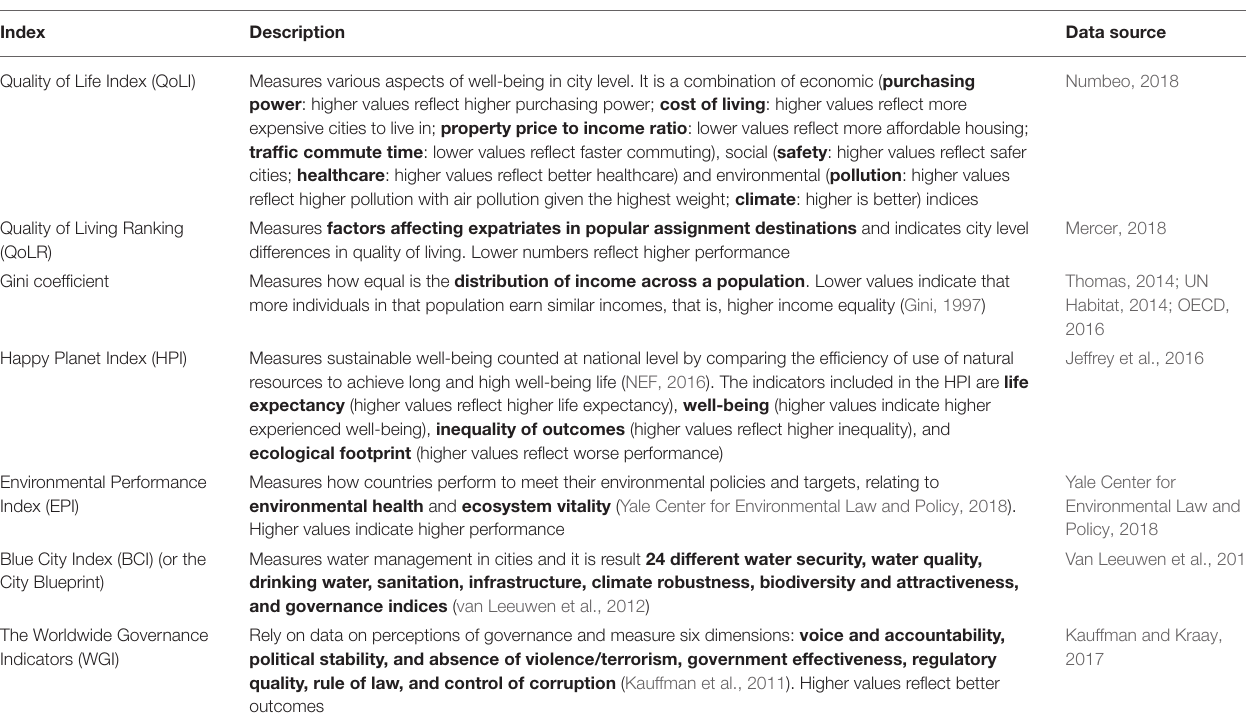
TABLE 1 | Livability and sustainability indices used in the